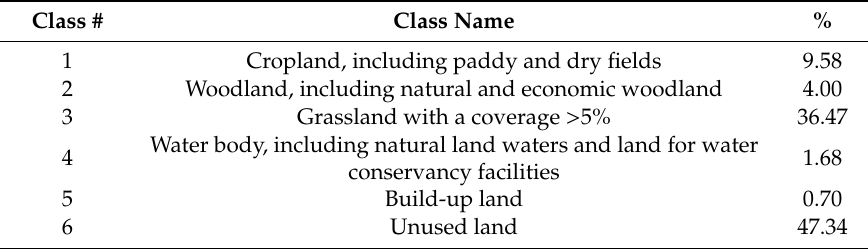
Table 1. Land cover types of Figure 1b and the percentages of each